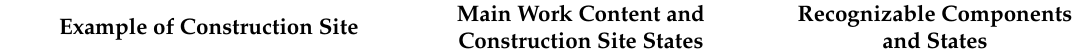
Table 2. Construction site states.